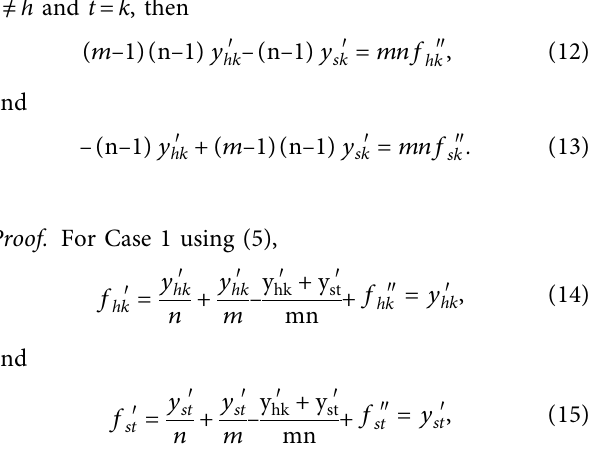
Figure 1: Observations in Table 1 with ( x , y , z ) � ( i , j , y